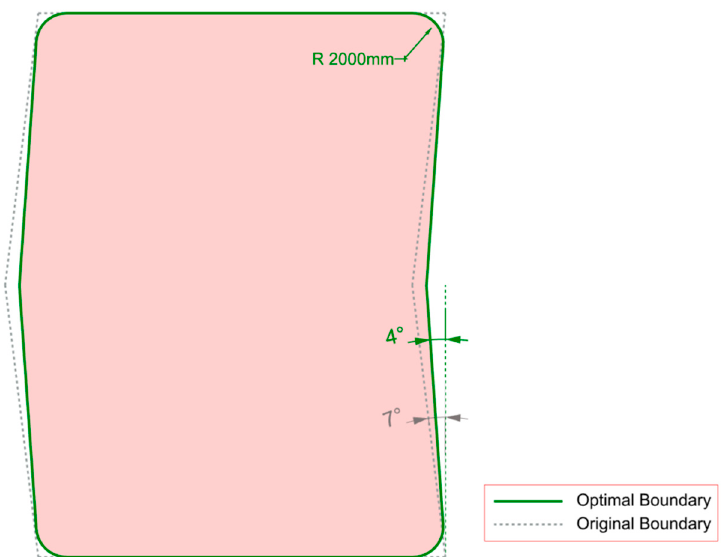
Figure 19. Optimal aerodynamic building layout.